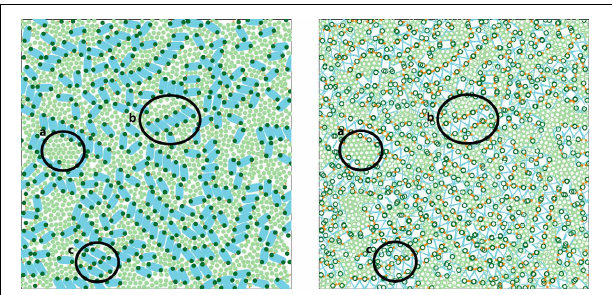
FIGURE 1 | Snapshot from a simulation of the coarse-grained model described in Schneider and Geissler (2013). The left panel shows the top (stroma-side-up) layer of the two-layer geometry, and the right panel shows an overlay of the particles in both layers. The system size is comparable to a granum in vivo : each square simulation box has a side length of 400nm and contains LHCII (green) and PSII (blue) particles at a total packing fraction of 0.75, with a stoichiometry of free LHCII trimers to PSII C 2 S 2 super- complexes of 6. Various self-assembled structural motifs are highlighted: (a) entropic ordering of LHCII particles; (b) stacking-mediated linear aggregates of PSII particles; (c) precritical nucleus of PSII C 2 S 2